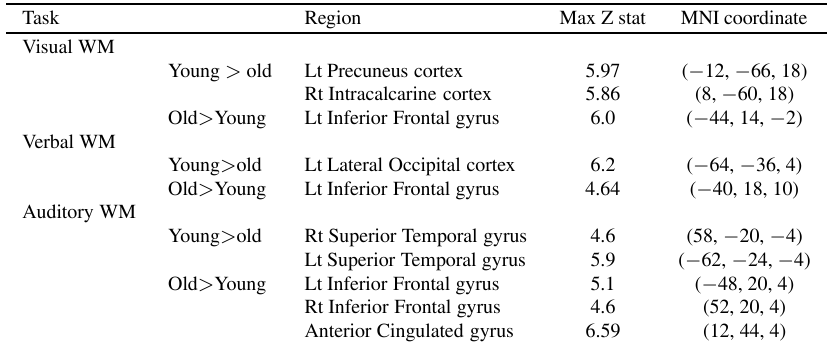
Table 3 Age-related activations in each